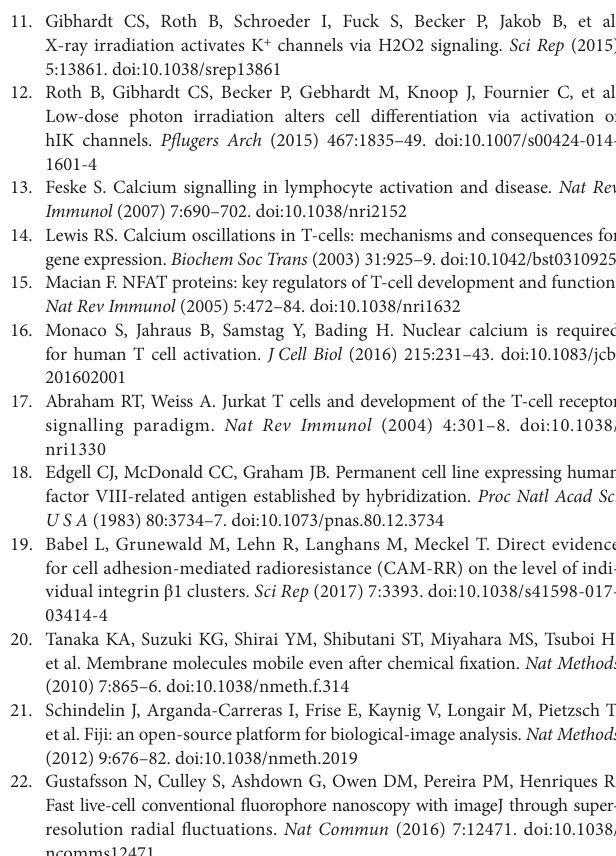
** P < 0.01. FigUre s2 | Irradiation stimulates immune activation in Jurkat cells. Western immune blots (a) and quantification (B) of Jurkat cells 48 h after irradiation with a dose of 1.25 and 2 Gy using an anti-CD25 antibody. Mock-irradiated cells served as a control ( n = 3). Immuno-fluorescent detection (scale bar = 25 µm) (c) and quantification (D) of interleukin-2 (IL-2) in control and Jurkat cells 48 h after irradiation with 2 Gy. Mean fluorescent intensity ± SD in region of interests (ROIs) in the cytoplasm of control cells and irradiated cells ( N = 2; n ≥ 10 cells). Immuno-fluorescent detection (scale bar = 25 µm) 10 (e) and quantification (F) of interferon- γ (IFN γ ) in control and Jurkat cells 48 h after irradiation with X-ray doses between 0.5 and 5 Gy or treatment with 25 µl/ml CD3/CD28/CD2 T-cell activator. Mean fluorescent intensity ± SE in ROIs of control cells and irradiated cells ( N = 3; n ≥ 70 cells). Data in (F) were fitted by Eq. 1 yielding a D50 value of 1 Gy and a maximum increase in fluorescence of